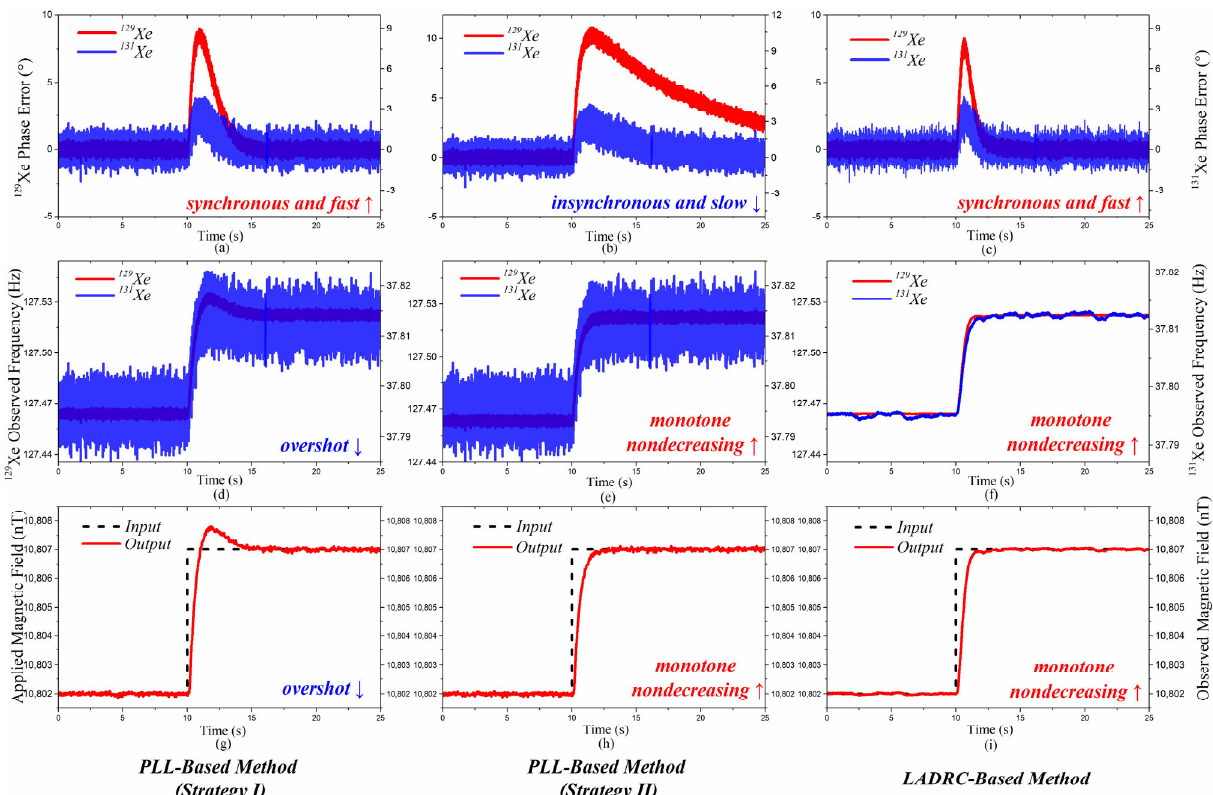
Figure 5. Experimental performance of the PLL ‐ based and LADRC ‐ based methods with a step input signal. ( a – c ) are the phase ‐ loop step response comparisons, ( d – f ) are the frequency ‐ loop step response comparisons and ( g – i ) are the observed magnetic field.